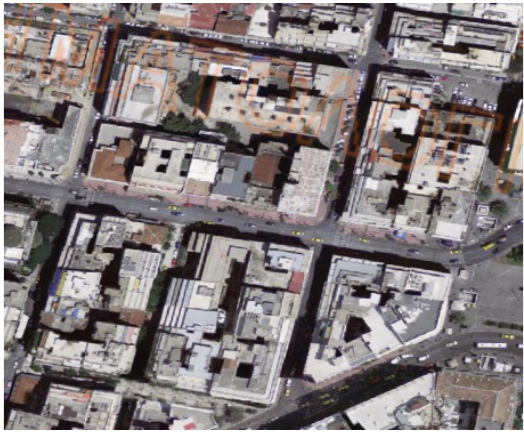
Figure 4. An orthophoto depicting the tested area of densely urbanized area in the centre of Athens, Greece